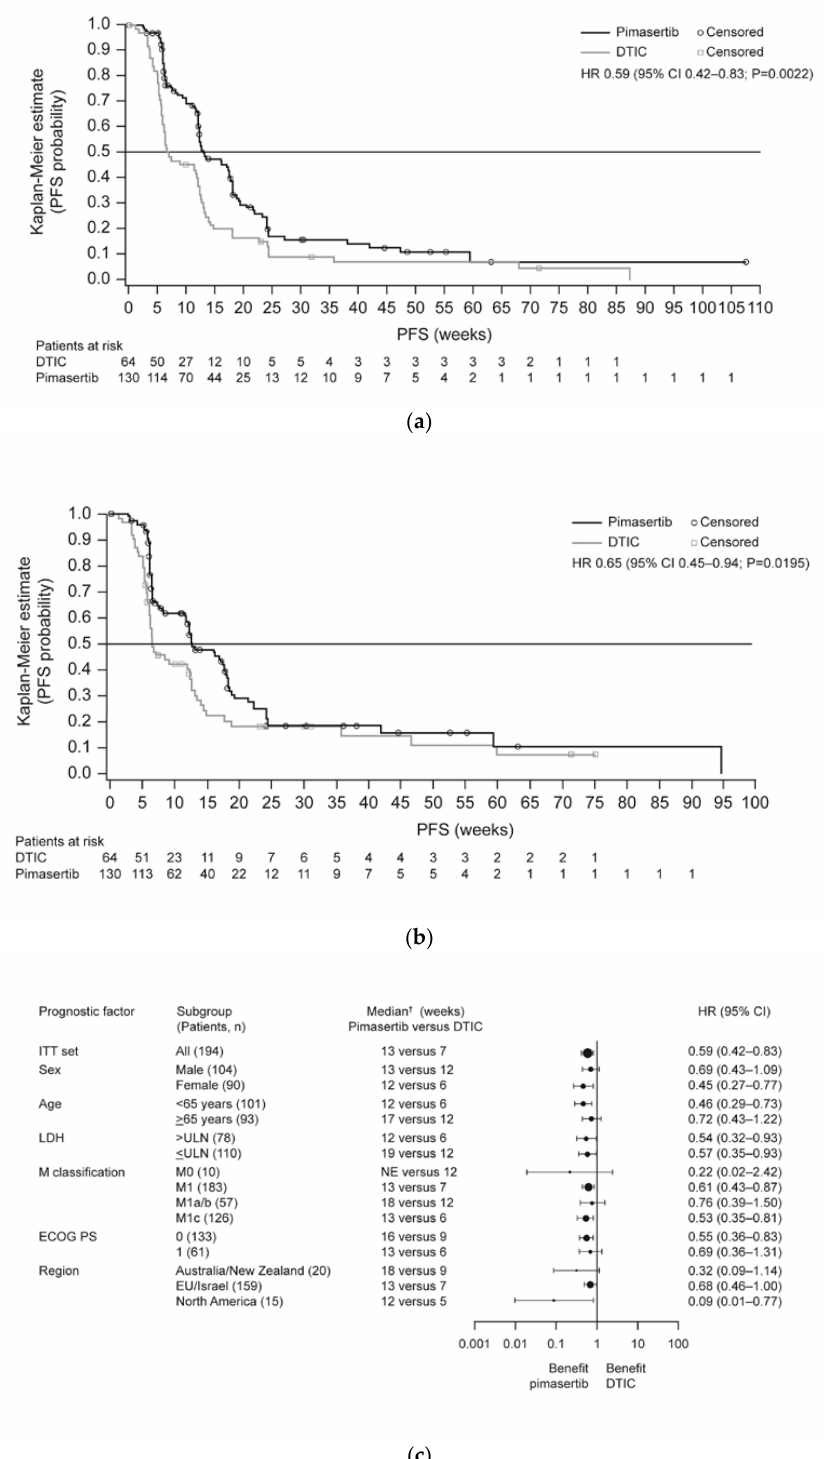
Figure 1. Kaplan-Meier plots of PFS for pimasertib versus DTIC based on endpoints: ( a ) read by investigator assessment (primary endpoint); ( b ) independent assessment of the data (sensitivity analysis); ( c ) forest plot of PFS for pimasertib versus DTIC based on investigator assessment (ITT analysis set). Abbreviations: CI, confidence interval; DTIC, dacarbazine; ECOG PS, European Cooperative Oncology Group performance status; EU, European Union; HR, hazard ratio; ITT, intent-to-treat; LDH, lactate dehydrogenase; NE, not evaluable; PD, progressive disease; PFS, progression-free survival; ULN, upper limit of